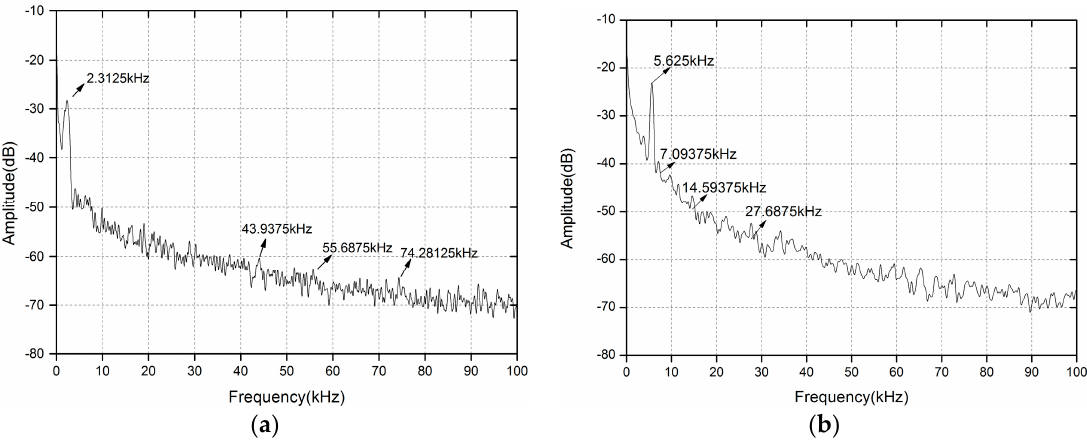
Figure 5. Typical Doppler signal displayed on the spectrum analyzer of different velocities with θ = 60°. ( a ) v = 3.585 mm/s; ( b ) v = 8.724 mm/s. ( a ) v = 3.585 mm/s; ( b ) v = 8.724